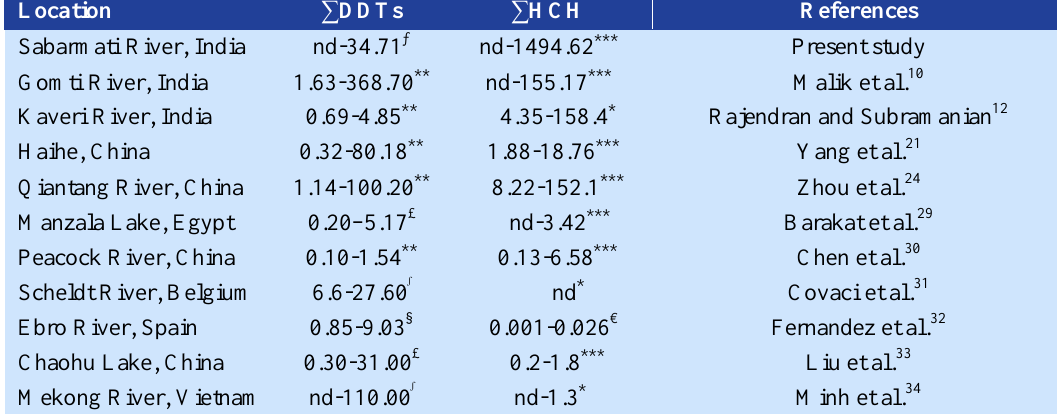
Table 4. Comparison of organochlorine pesticides (OCP) concentrations in sediment samples from various locations in the world